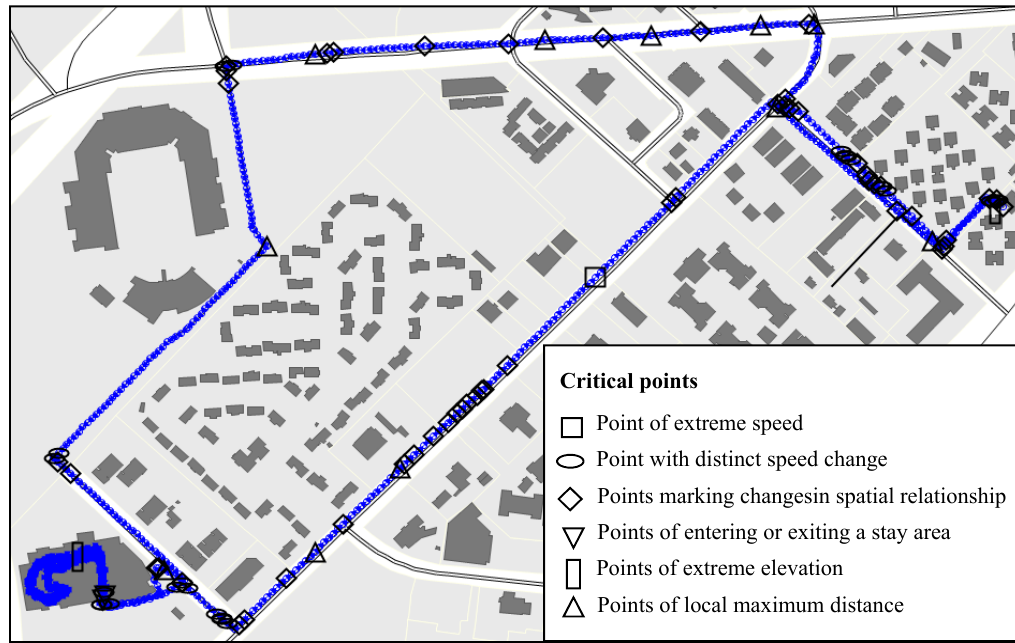
Figure 8. Critical points identified by applying ESTC to the GPS data of Trajectory 1. Table 1. Points and critical points preserved by DP and EDP algorithms for Trajectory 1.